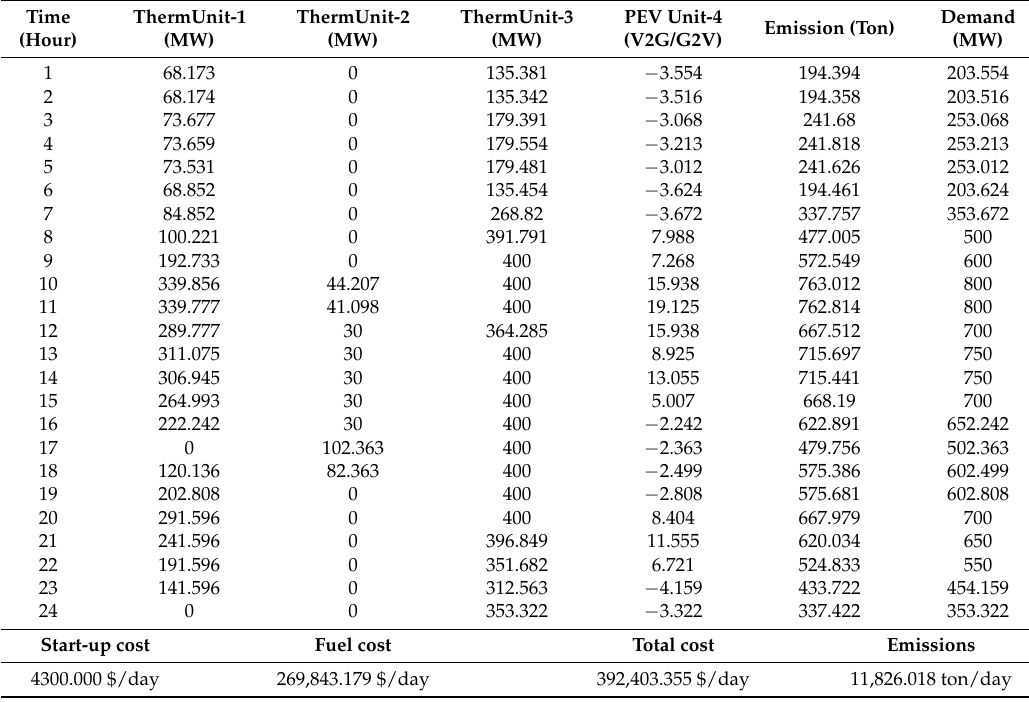
Table 6. Integration PEVs (V2G/G2V) with base 3 thermal generating units’ applying the